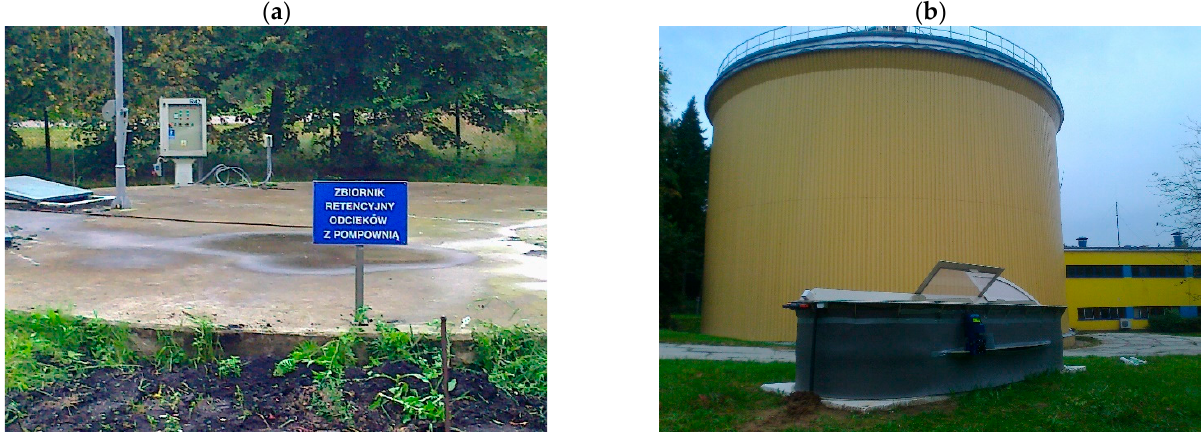
Figure 3. LF-DSS storage tank ( a ), enclosed digester and chamber filter press building, with the H-PBR in the foreground ( b ).